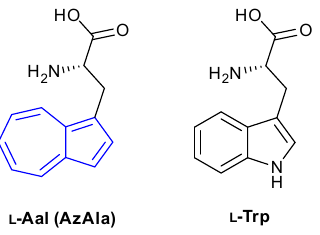
Figure 13. Non-canonical amino acid Aal (AzAla).